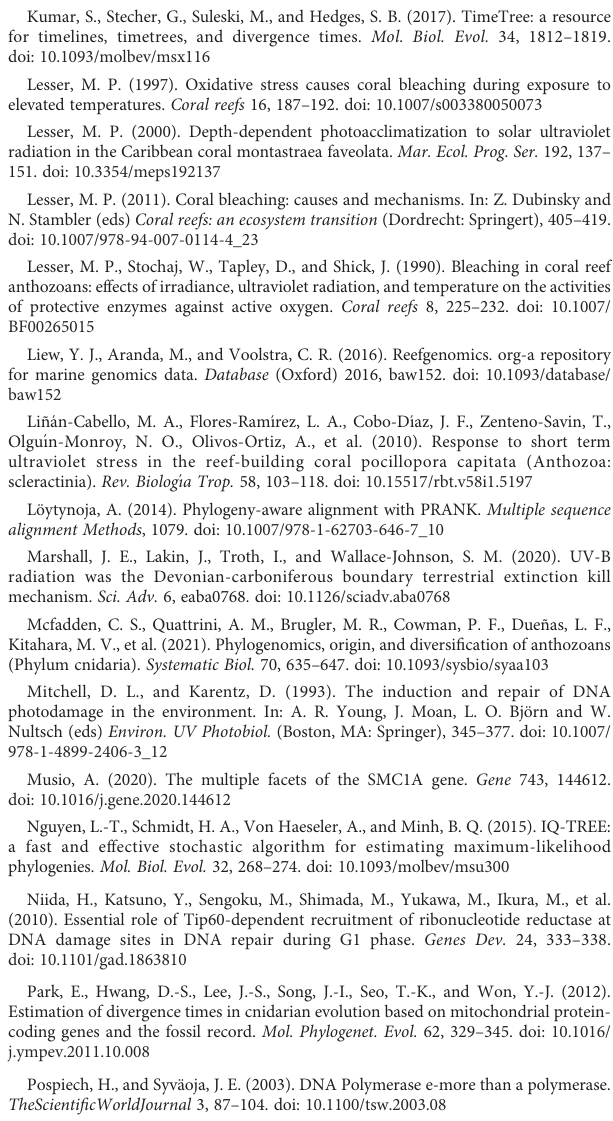
SUPPLEMENTARY TABLE 5 The overlap between the speci fi c amino acid changes for living stony corals and positive selection sites.